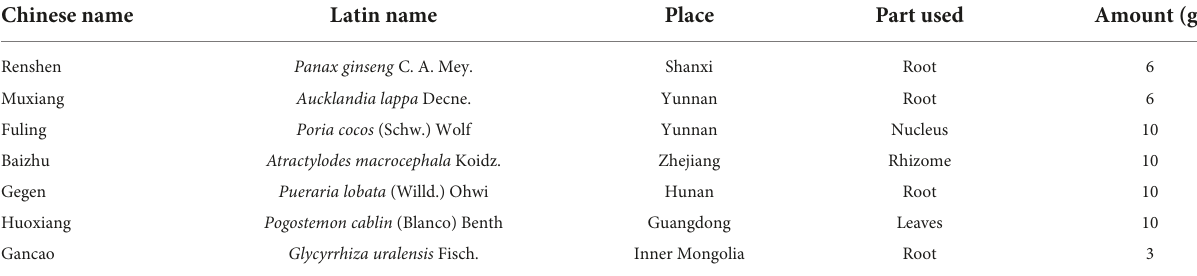
TABLE 1 The ingredients of